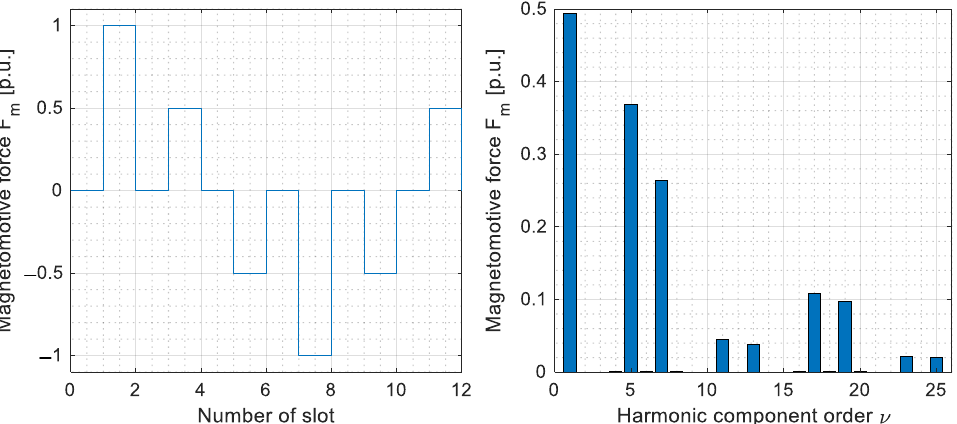
Figure 3. Magnetomotive force step curve and its spectrum produced by single-layer winding q = 2/5 with 10 poles.